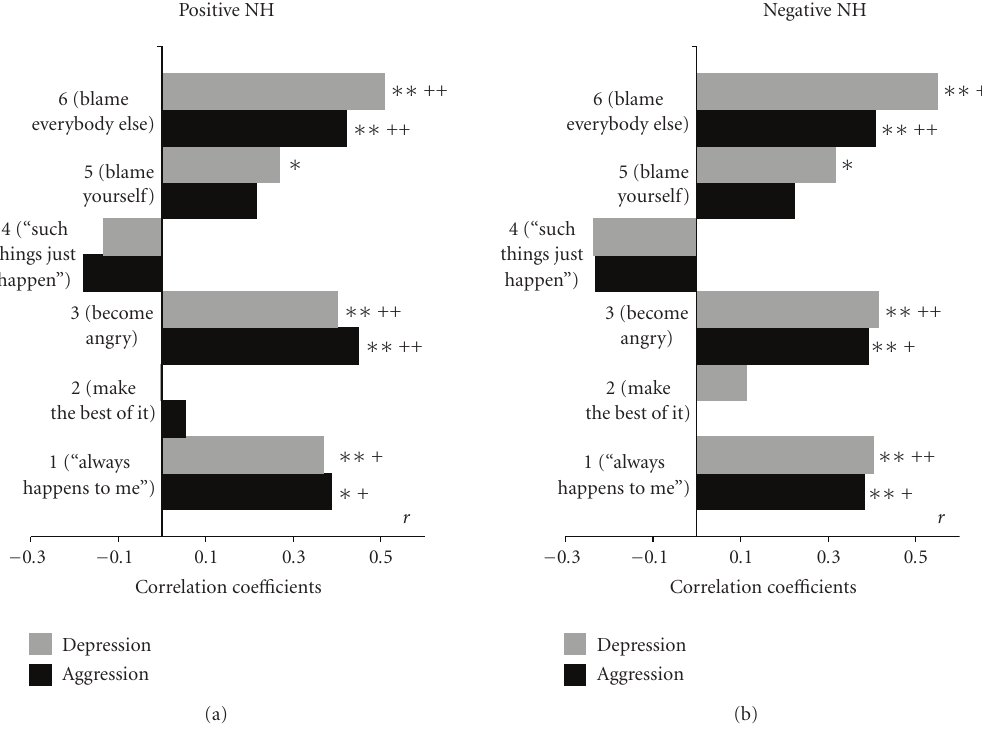
Figure 3: correlations of factors Depression and Aggression with QDF scales for nonhuman conditions; withdrawal of positive reinforcers: posNH, (a); encounter with negative reinforcers: negNH, (b) ( ∗ P < . 05; ∗∗ P < . 01; + P < . 05; ++ P < . 01 after Bonferroni